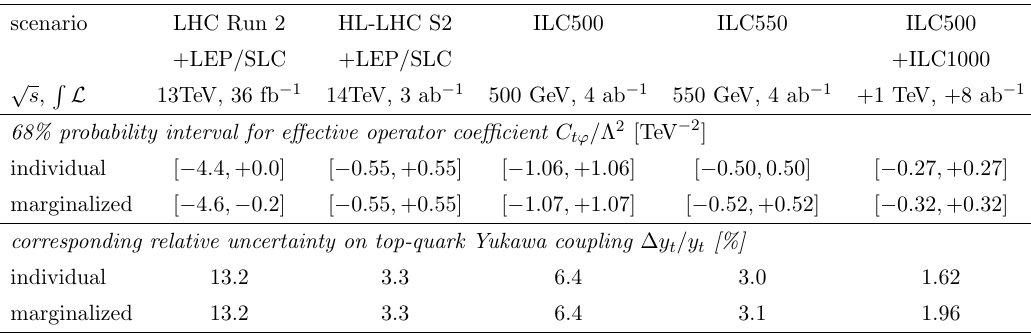
Table 4 . The 68% probability intervals for C t’ = (cid:3) 2 and the corresponding precision on the top- quark Yukawa coupling. The results of the (cid:12)rst four columns correspond to the ten-parameter (cid:12)t that we used to obtain the results of (cid:12)gure 4. The results for the scenario with ILC runs at two di(cid:11)erent center-of-mass energies in the last column were obtained with the extended seventeen- parameter (cid:12)t presented in section